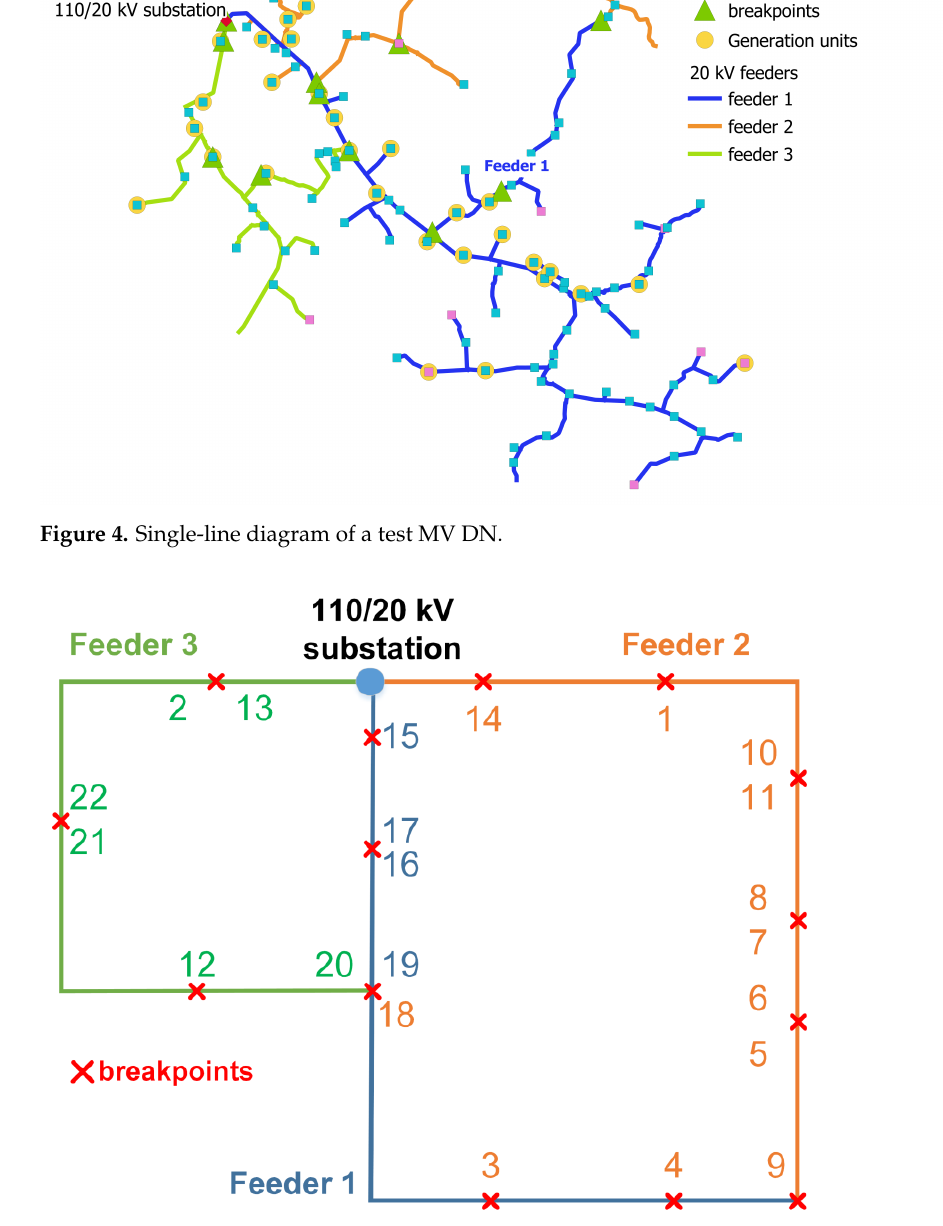
Figure 5. Schematic presentation of the locations of breakpoints in a test MV